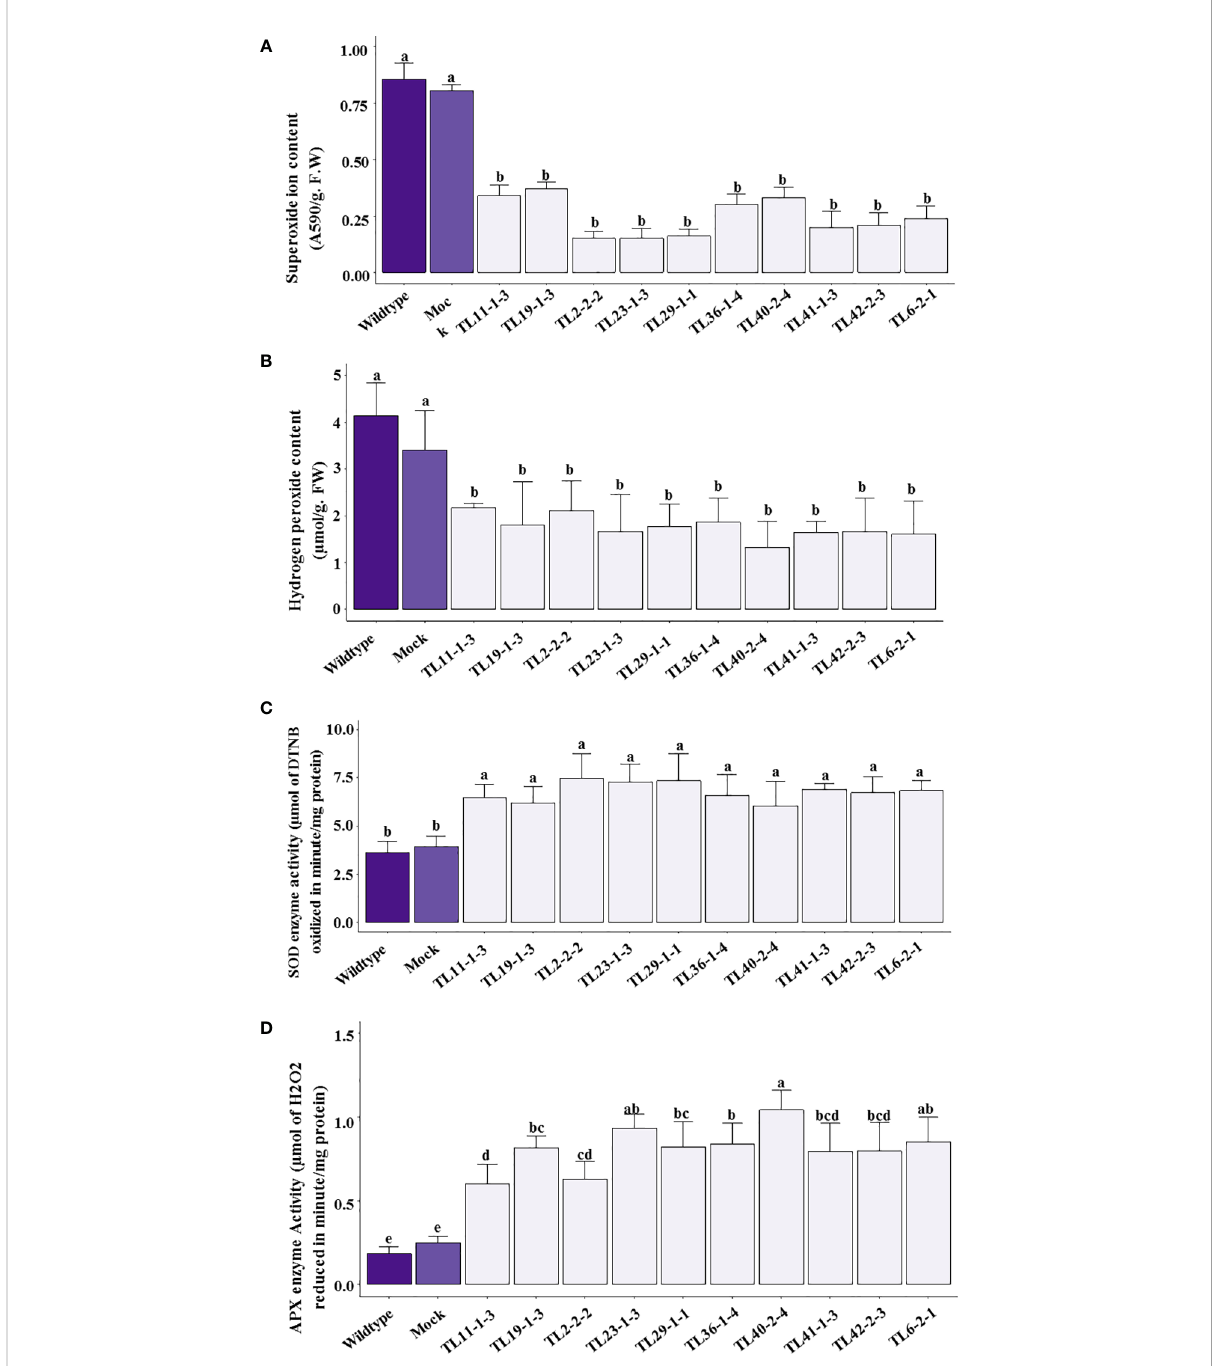
FIGURE 9 Reactive oxygen species (ROS) and anti-oxidative enzyme ef fi cacy in multigene transgenic plants, wild type and mock plants under drought stress: (A) . superoxides, and (B) . hydrogen peroxide content), (C) . superoxide dismutase (SOD) and (D) . ascorbate peroxidase (APX) activity in wild type, mock and multigene transgenic groundnut plants under drought stress conditions. The values are mean of three biological replicates (n=3) and error bars denotes standard error. The alphabets on the error bars indicates signi fi cant variation (p<0.05) between transgenic lines, wild type and mock